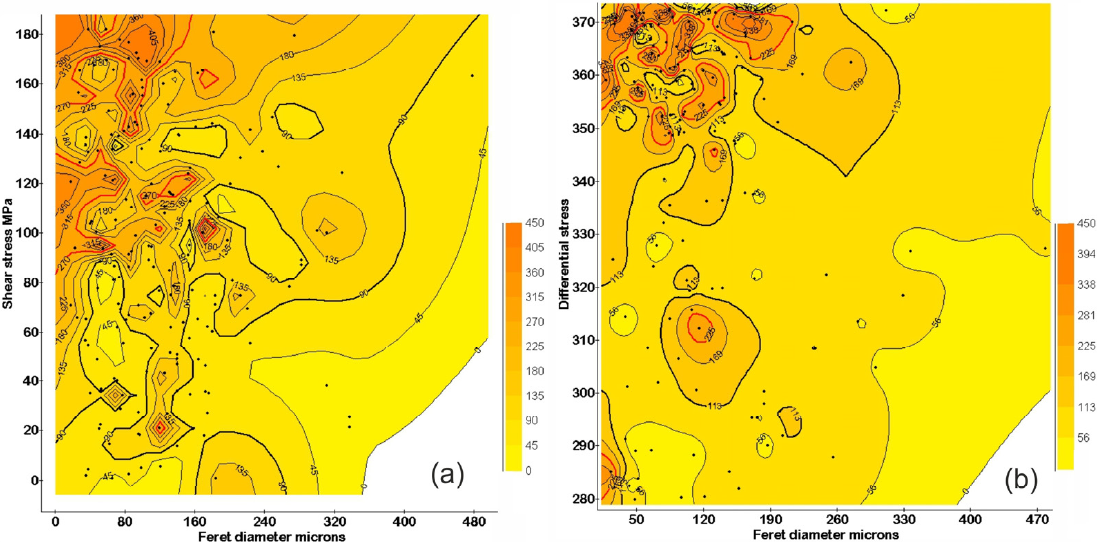
Figure 13. ( a ) Resolved shear stress along the twinning vector plotted against grain size (Feret diameter) and contoured for twin density (mm − 1 ). Individual grains are shown as black points. There are few large grains included in the traverse. There is a general trend of twin density increasing with shear stress and decreasing with grain size, plus short-period fluctuations in twin density, corresponding to the scatter shown in Figure 12; ( b ) Differential stress plotted against grain size (Feret diameter) and contoured for twin density (mm − 1 ). General behavioural trends are the same as in ( a ).